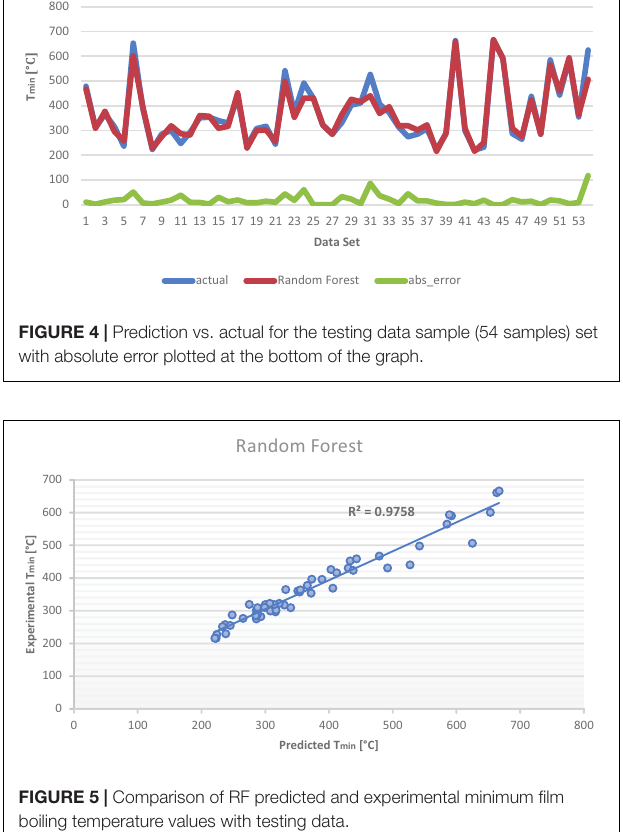
FIGURE 5 | Comparison of RF predicted and experimental minimum film boiling temperature values with testing data.